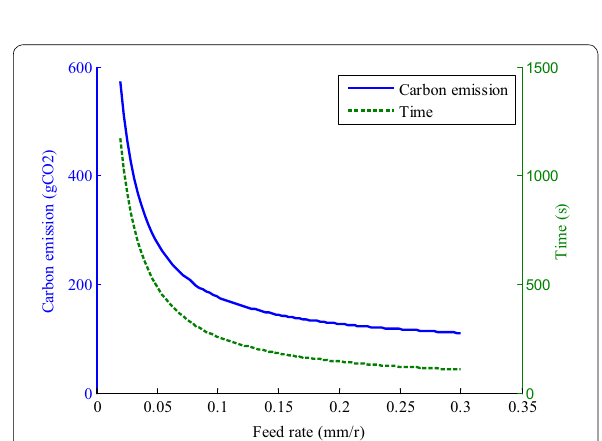
Figure 11 Influence of feed rate on the optimization target